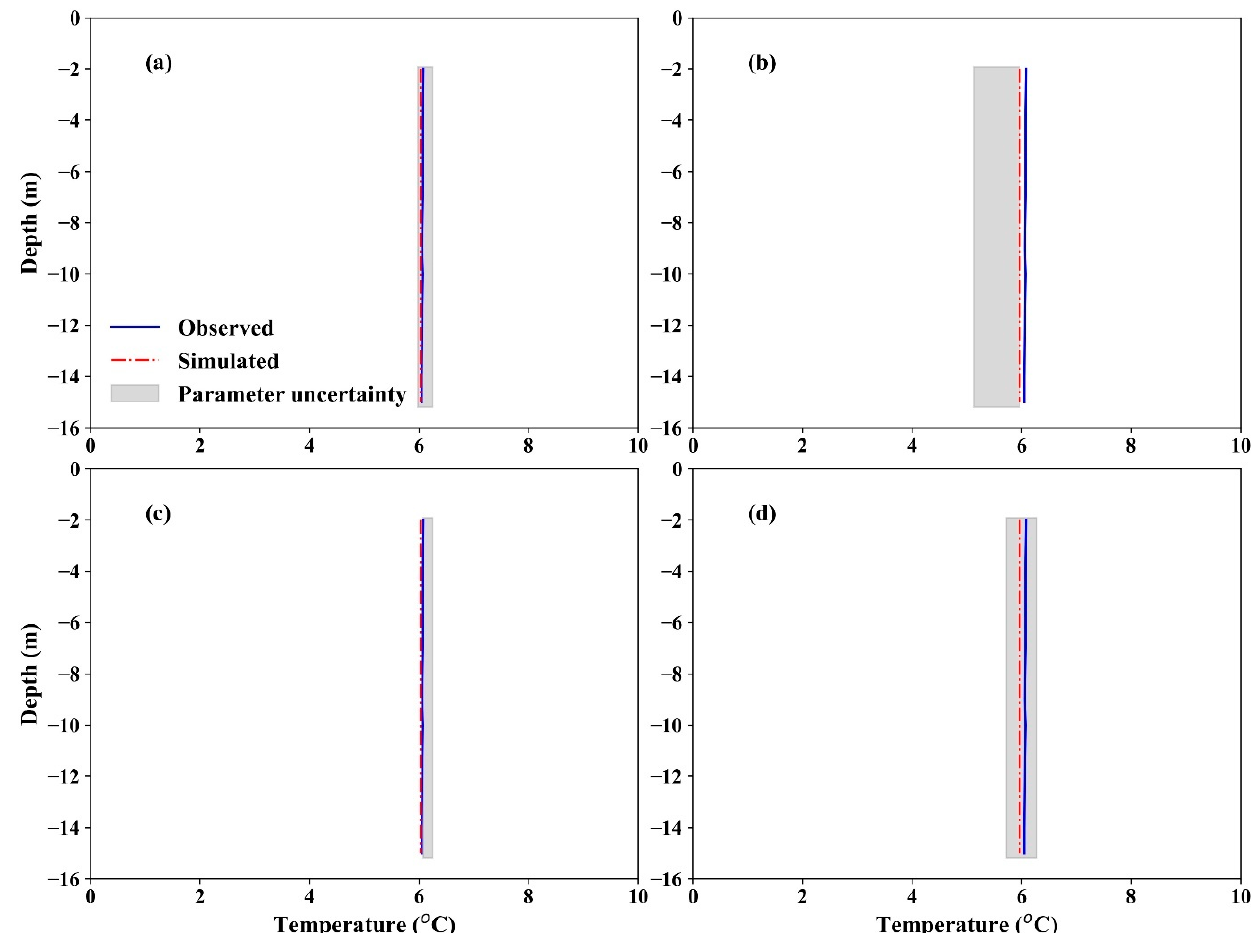
Figure 8. Observed (red) and simulated (blue) water-temperature profiles for segment 50 on 4 November 2009. The shaded areas represent the ranges of temperature simulated by using the final 10 parameter values that were in memory. ( a , b ) Calibration with 50 runs by IGHS and PSO, respectively; ( c , d ) same as ( a , b ) but with 100 runs in calibration.